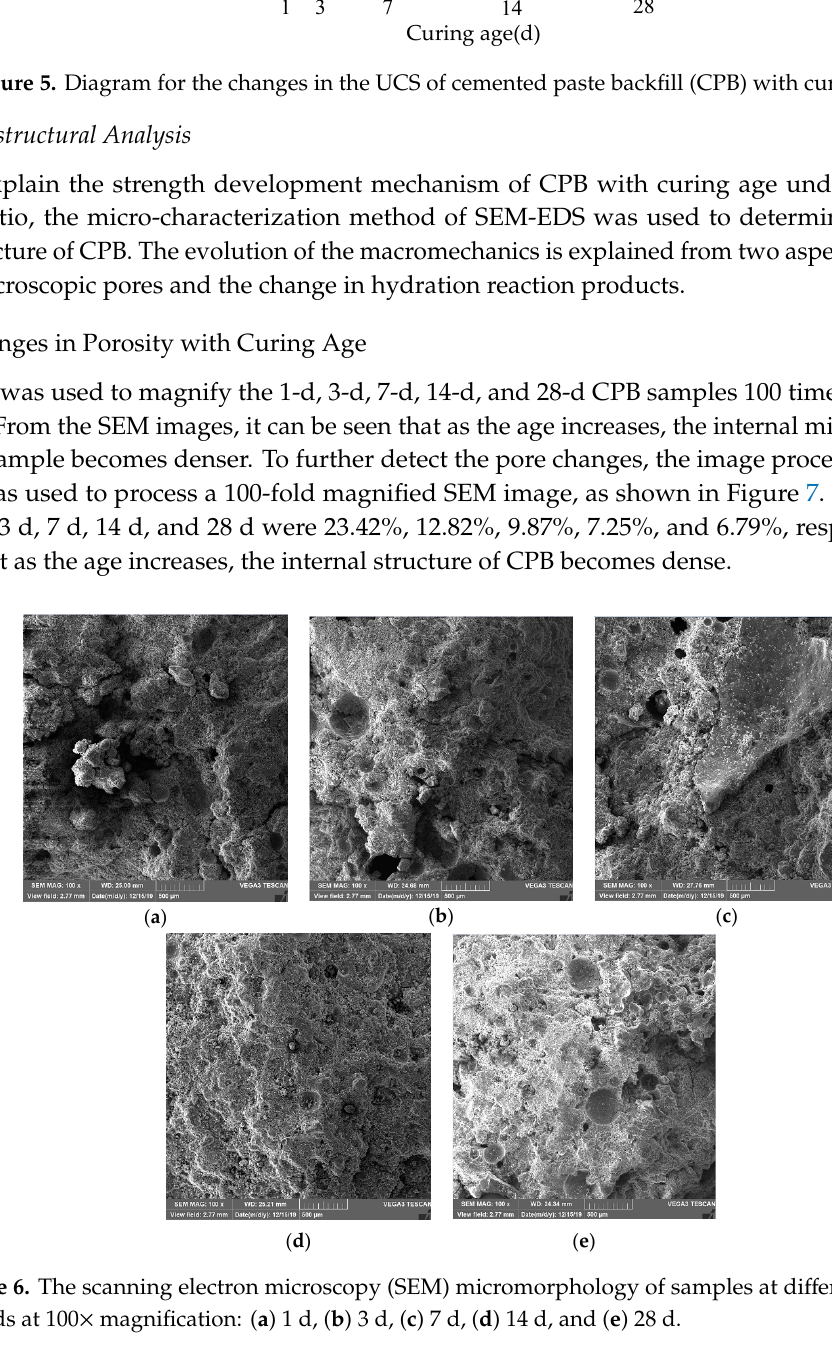
( e ) Figure 7. Pore structure analysis at different curing periods: ( a ) 1 d of pore structure analysis, ( b ) 3 d of pore structure analysis, ( c ) 7 d of pore structure analysis, ( d ) 14 d of pore structure analysis, and ( e ) 28 d of pore structure analysis.